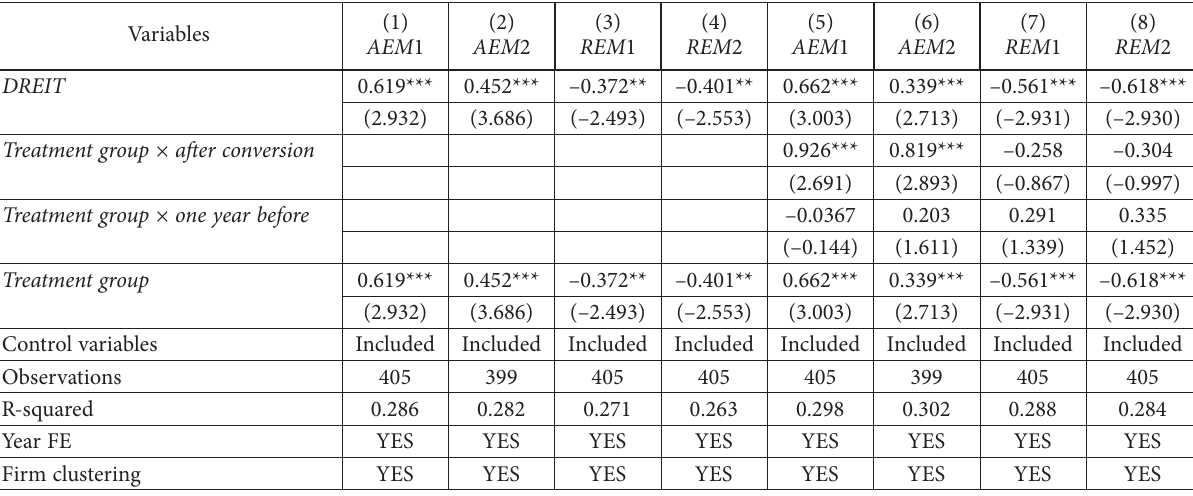
Table 8. Panel B test on propensity-score matched samples